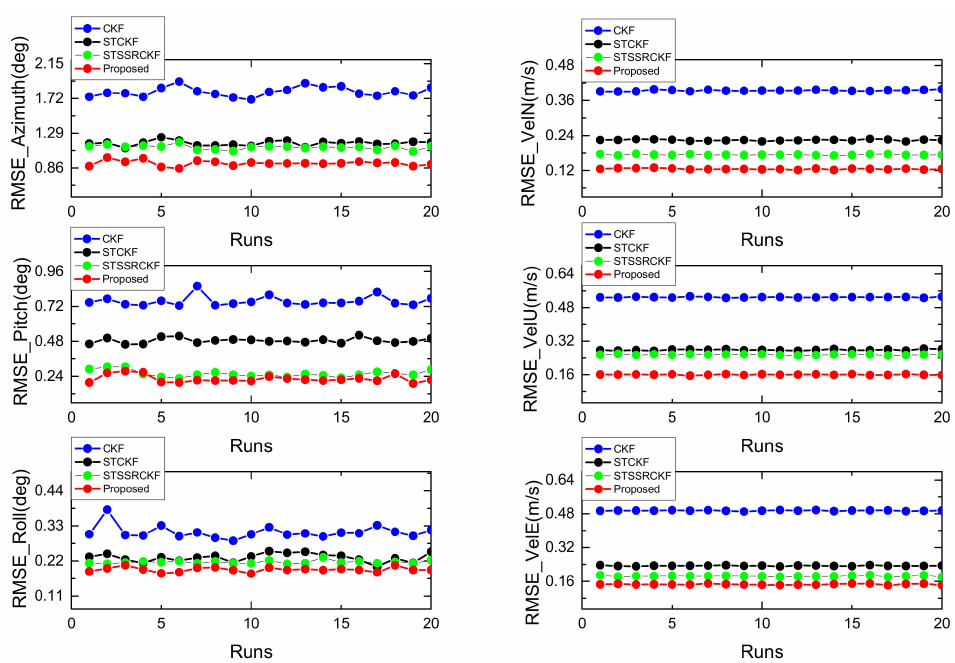
Figure 9. The RMSEs of attitude error ( left ) and velocity error ( right ) when M =